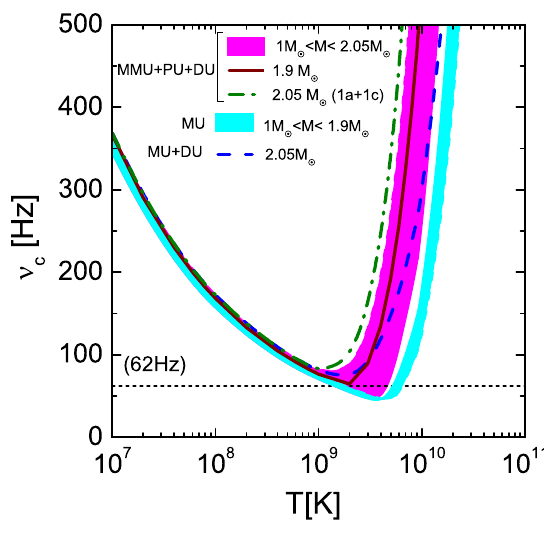
Figure 12. Figure from [93]. Critical frequency of the r -mode instability as a function of the temperature for a band of neutron star masses. Dashed line shows calculation with MU + DU for M = 2.05 M The solid line demonstrates calculation done for the threshold mass of the DU processes within MMU + PU + DU scenario. The dashed-dotted line shows calculation with MMU computed with 1a + 1c curve in Figure 9 for M = 2.05 M (cid:12)